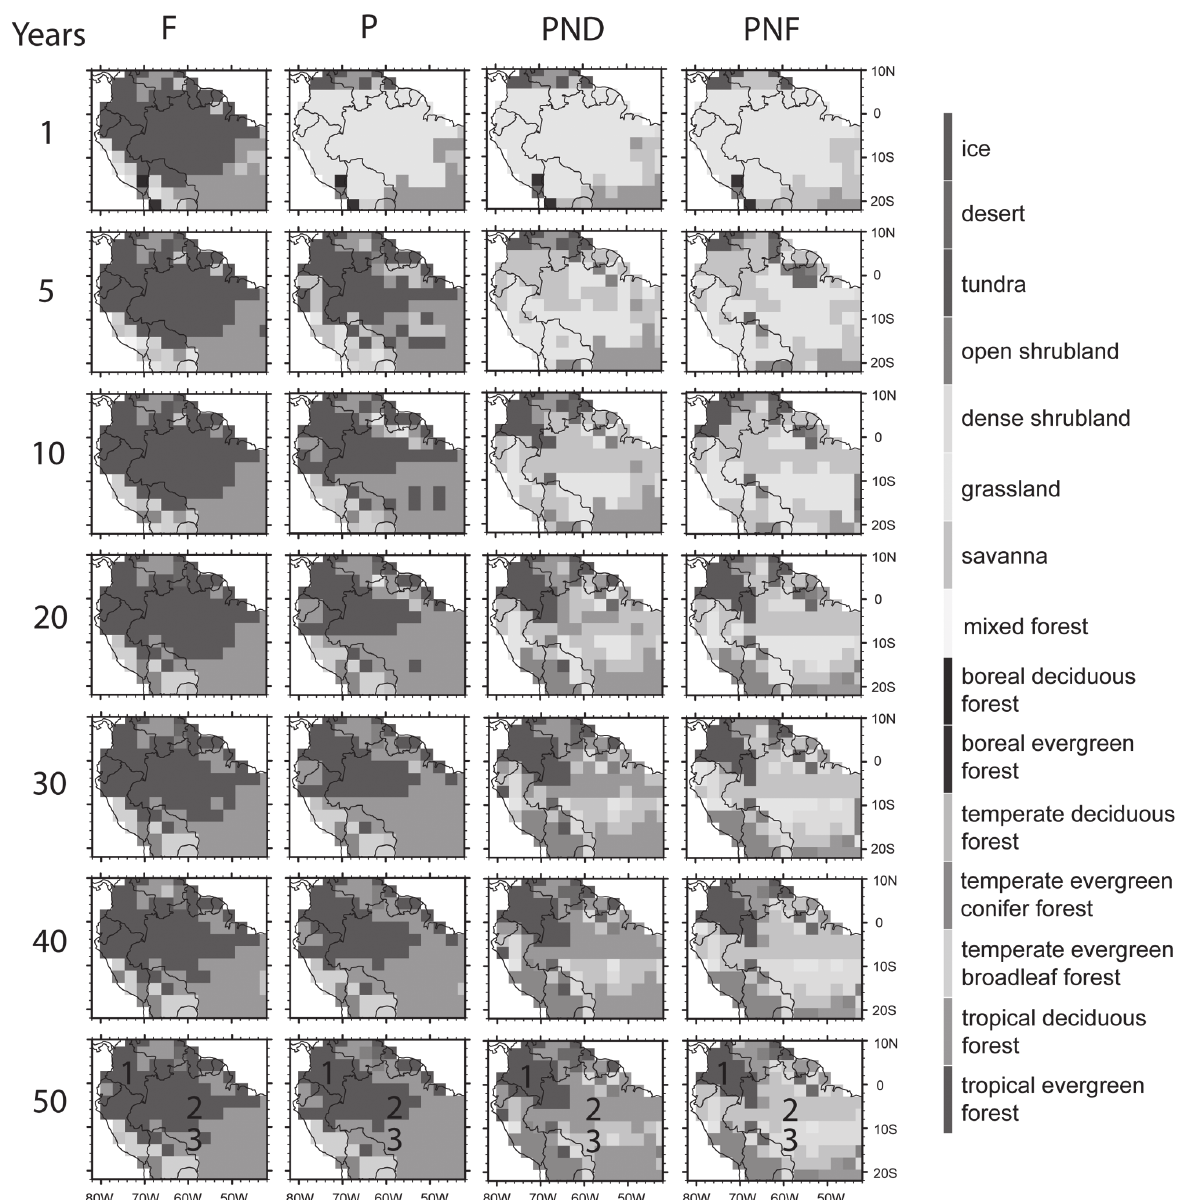
Fig. 1 - The simulated land cover chronosequence. The numbers 1, 2, and 3 represent the regions over Colombia and northwestern state of Amazonas in Brazil, over central Amazonia above 10° S, and over southern Amazonia below 10° S (northern state of Mato Grosso), respectively. These regions were chosen because of the distinct simulated land cover after 50